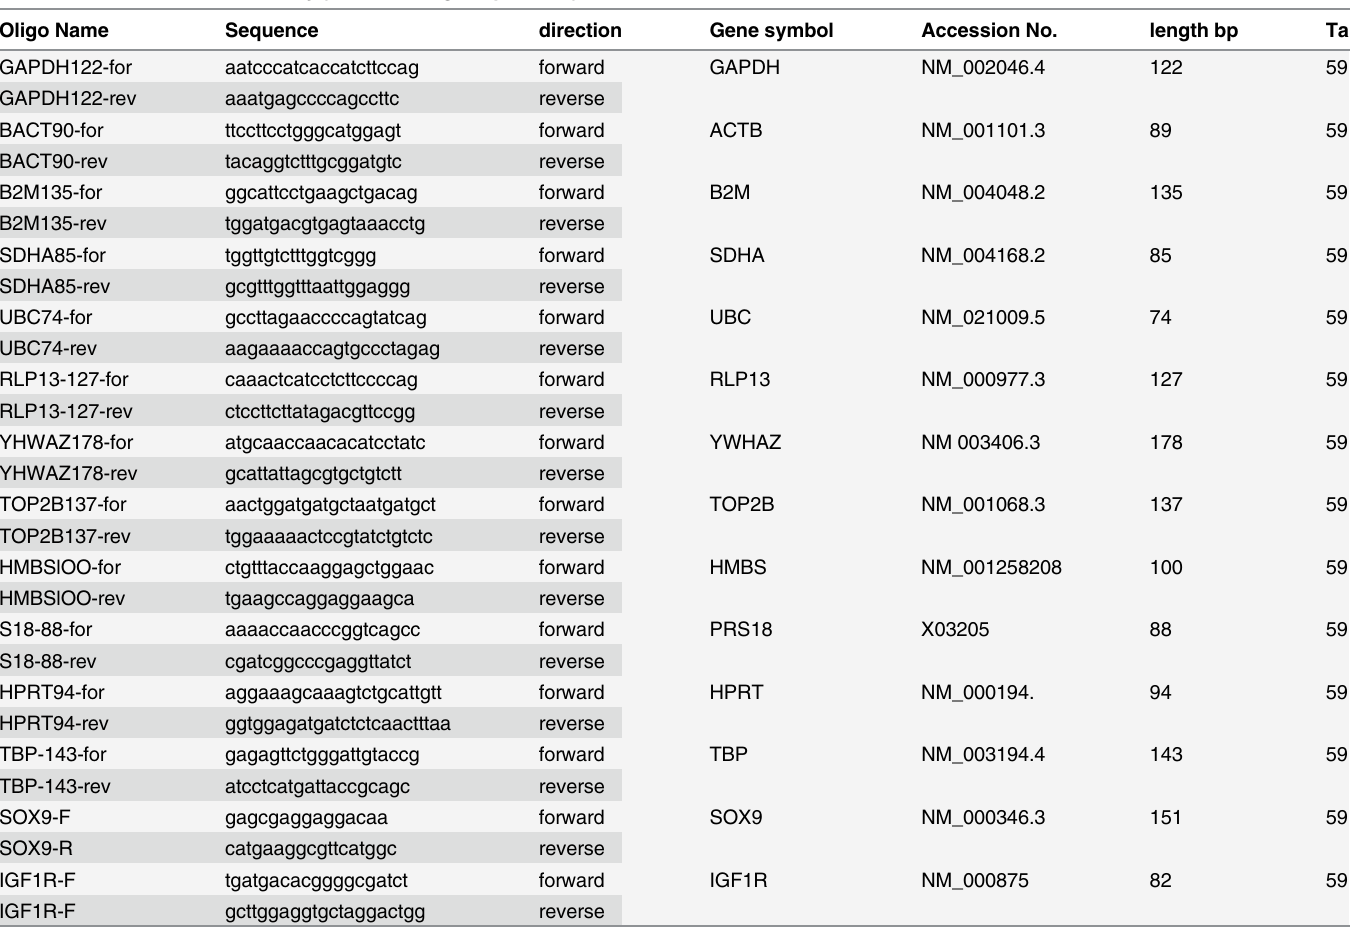
Table 1. Primers used in the study (Ta: annealing